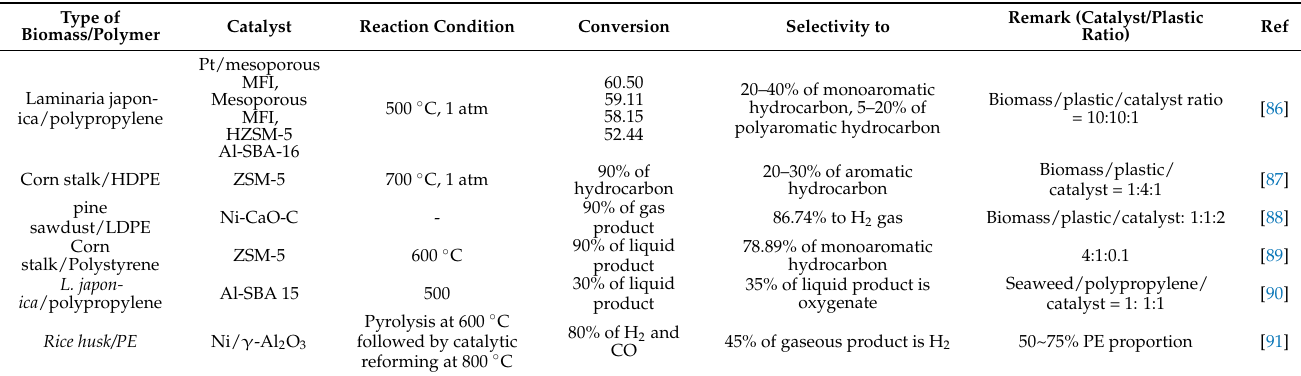
Table 3. Effect of co-feeding with other